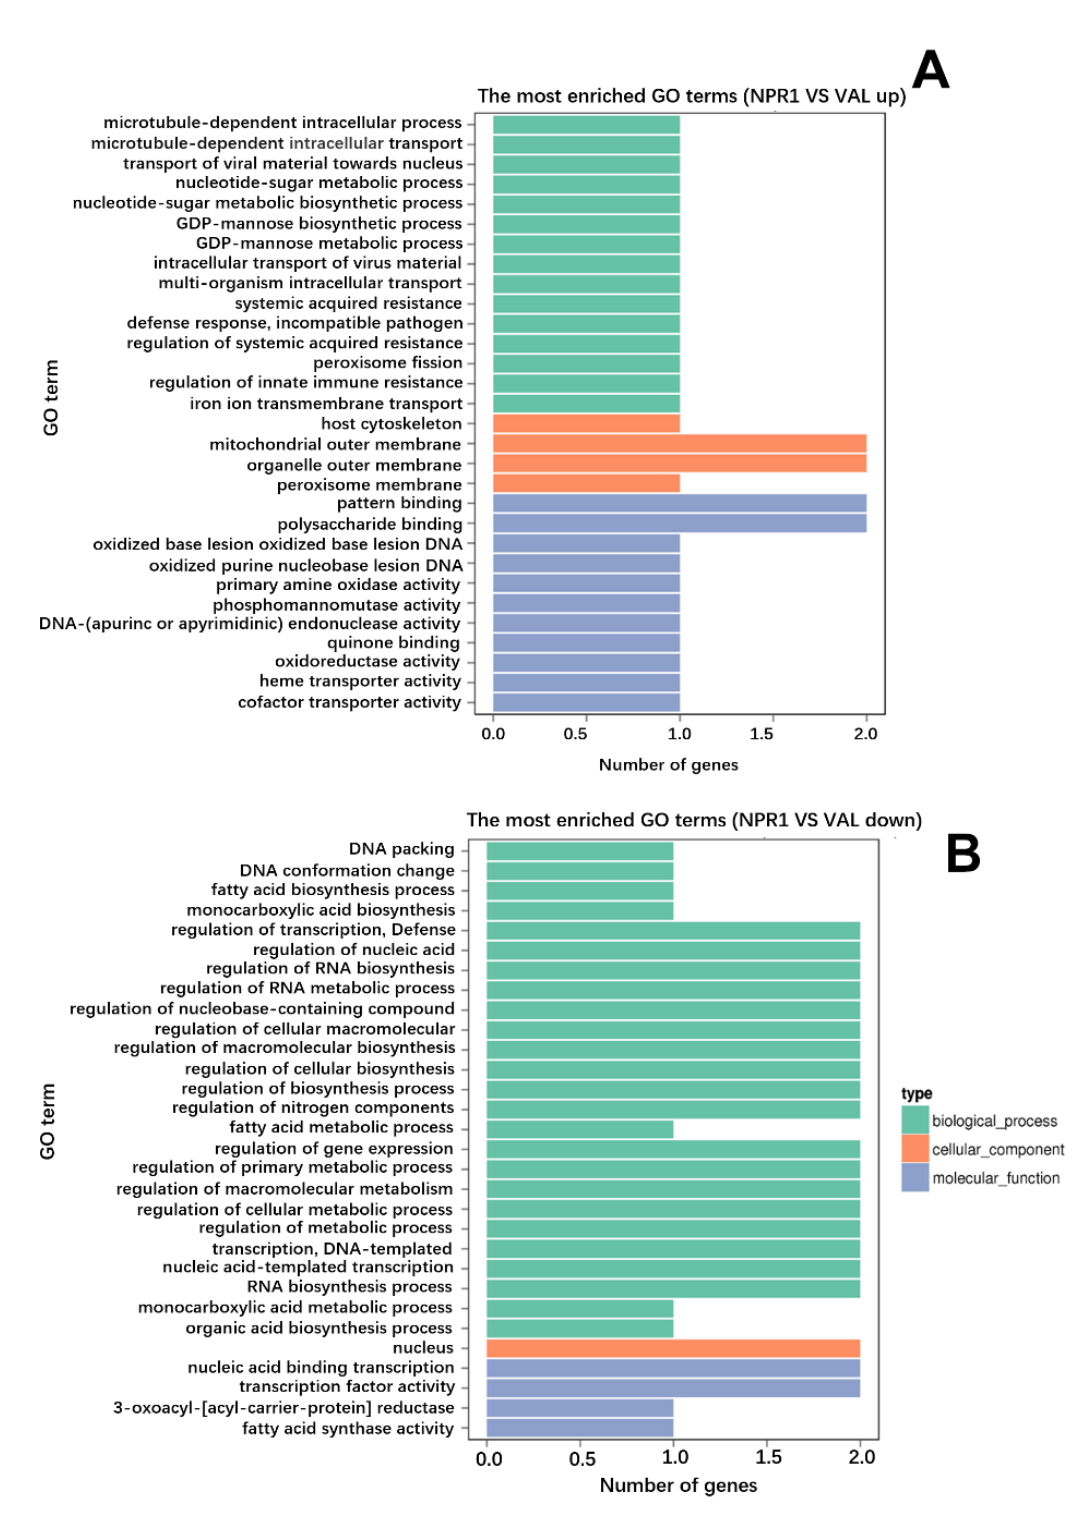
Figure 3. Gene ontology (GO) term enrichment analysis. ( A , B ) The GO enrichment terms of (A) upregulated (B) and downregulated DEGs. In the x-axis the number of DEGs is represented, and in the y-axis the GO terms enriched. Different colors are used to distinct biological process, cellular components, and molecular function.